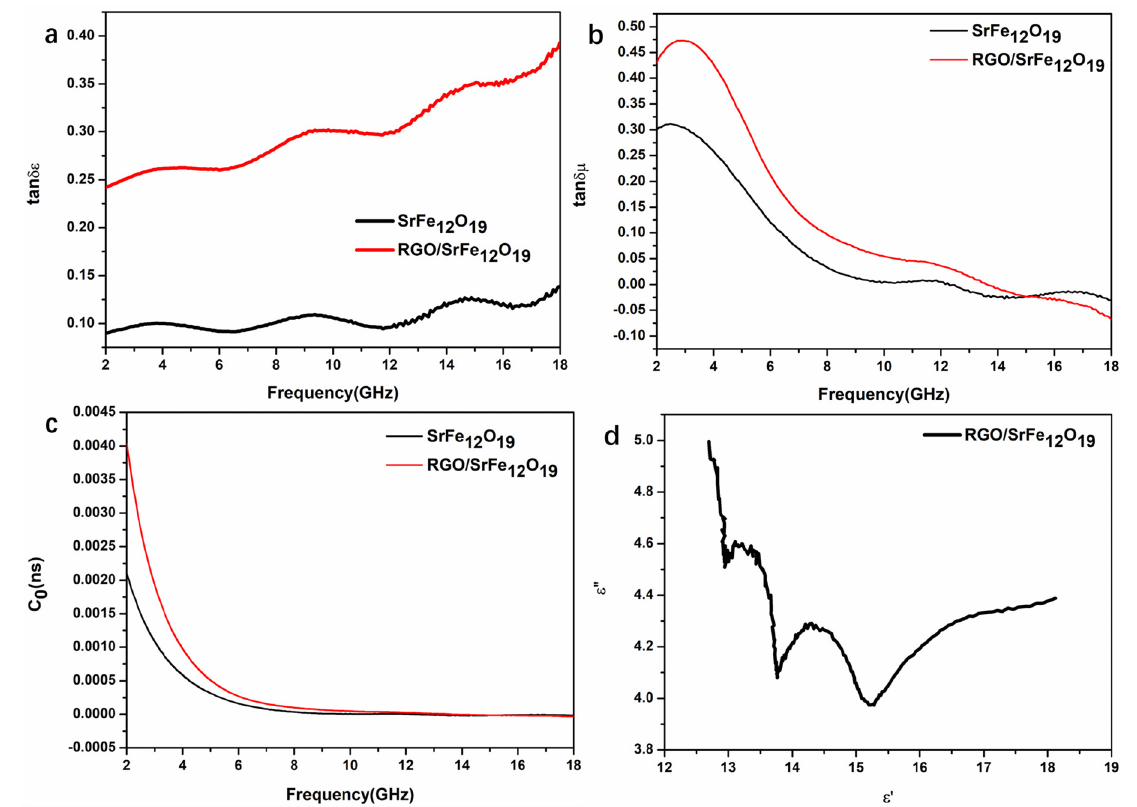
Figure 5: Frequency dependence of (a) dielectric loss factor ( tan δε ); (b) magnetic loss factor ( tan δµ ); (c) C 0 values of SrFe 12 O 19 nanoparti- cles and RGO/SrFe O nanocomposites; (d) Cole-Cole semicircle ( ε ′′ versus ε ′ ) of RGO/SrFe 12 19